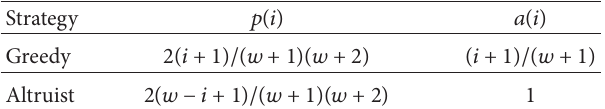
Table 1: The descriptions for greedy and altruist strategies.